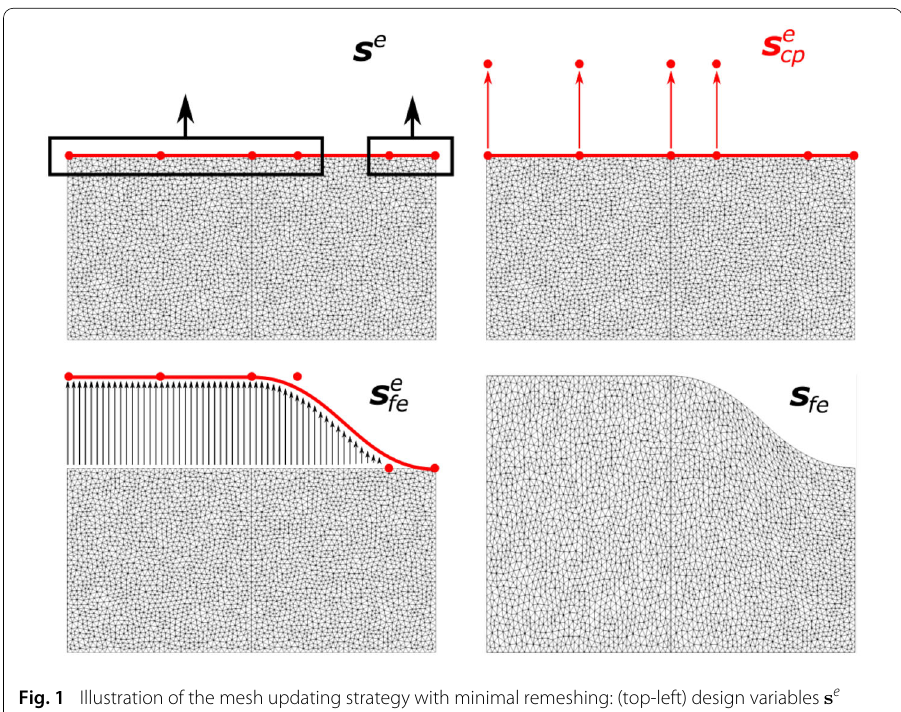
Fig. 1 Illustration of the mesh updating strategy with minimal remeshing: (top-left) design variables s e defined as a subset of edge control points DOF; (top-right) edge control points displacement s e cp = C e s s e ; (bottom-left) edge FE nodes displacement s e fe = ( C e FFD ) T s e cp ; (bottom right) all FE nodes displacement s